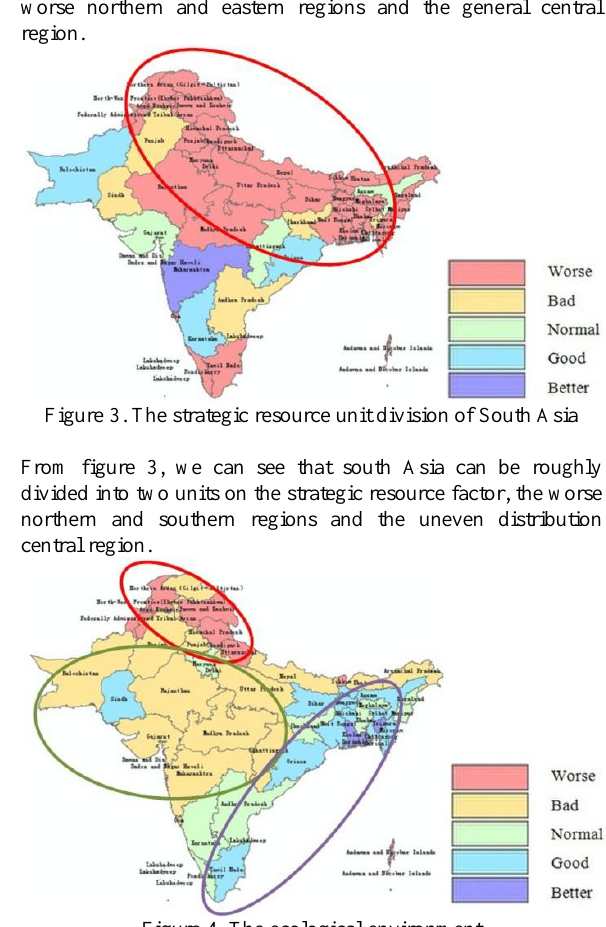
Figure 4. The ecological environment unit division of South Asia From figure 4, we can see that south Asia can be roughly divided into three units on the ecological environment factor, the worse northern region, the general central region and the better eastern coast region.